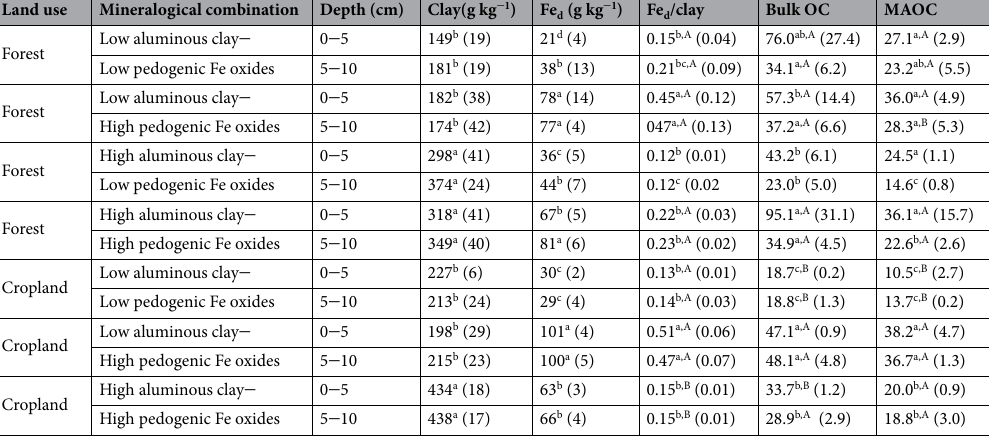
Table 1. Mineralogical combinations and their related amount of aluminous clay (clay) and dithionite- citrate-bicarbonate-extractable Fe (Fe d ), and respective Fe d to aluminous clay ratios (Fe d /clay). Organic carbon contents are given for bulk soil (Bulk OC) and the heavy fraction (MAOC). Aluminous clay represents the weight sum of kaolinite and gibbsite present in the < 2-µm fraction. Lower case letter denote significant differences within a certain land use and soil depth; capital letters indicate significant differences between land-use types for a given mineralogical combination. Sample numbers for the combinations are as follows: ‛ low clay ‒ low Fe’ under forest (n = 4), ‛ low clay ‒ high Fe’ under forest (n = 4), ‛ high clay ‒ low Fe’ under forest (n = 3), ‛ high clay ‒ high Fe’ under forest (n = 7); all cropland combinations (n = 3); mean and standard deviation in